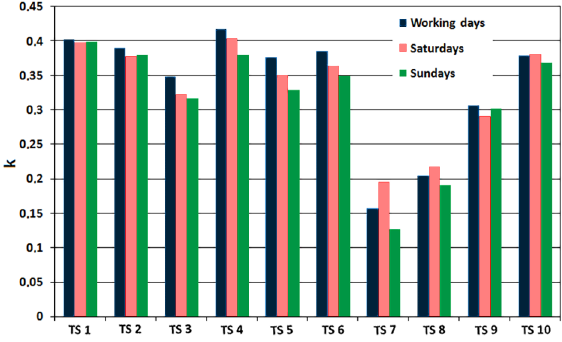
Fig. 15. Relative time of resistor breaking in supply areas of several